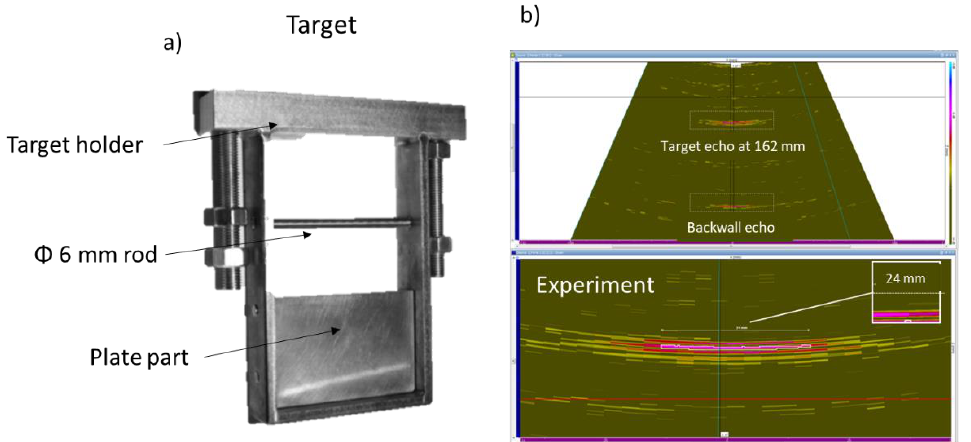
Figure 1. ( a ): Picture of the target used for liquid sodium test with the previous EMAT. ( b ): Ultrasonic Figure 1. a): Picture of the target used for liquid sodium test with the previous EMAT. b) : Ultrasonic scanning images during liquid sodium scanning images during liquid sodium testing.